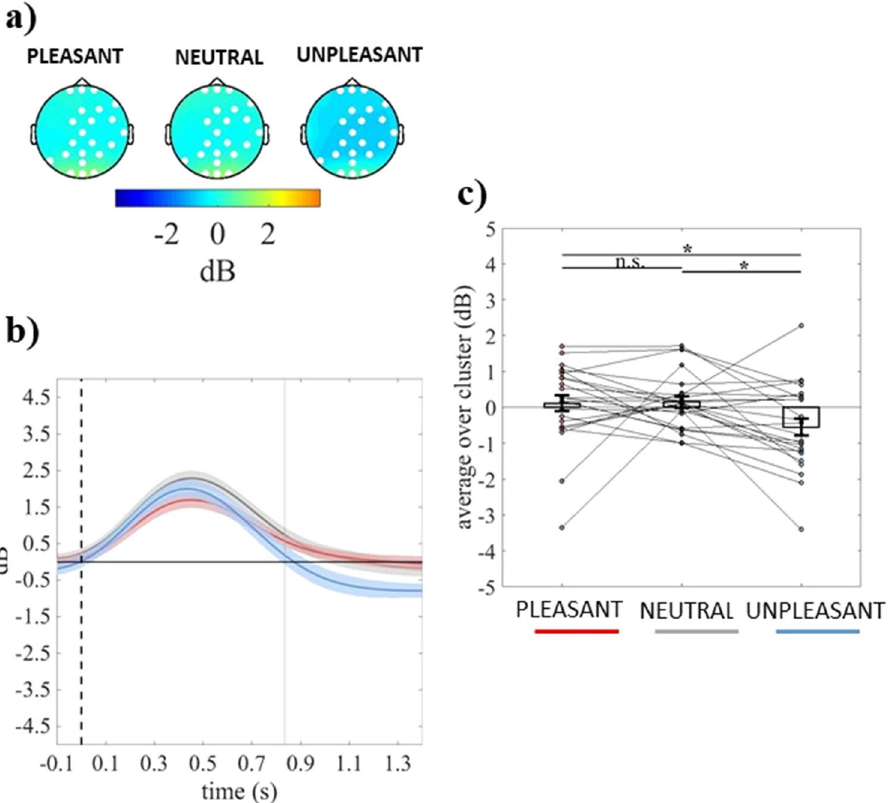
Figure 5. ( a ) Topography of the mean event-related theta power (dB) of individuals without dysphoria averaged over the significant time points (836 to 1400 ms time window) for pleasant, neutral, and unpleasant conditions. ( b ) Time course of grand-average event-related theta power of individuals without dysphoria averaged over the significant electrodes for pleasant (red line), neutral (grey line), and unpleasant (light blue line) conditions. Shaded areas represent ± standard error of the mean (SEM) and the gray line represents the beginning of the significant time window (836 ms). ( c ) Mean event-related theta power of each participant (in the group without dysphoria) averaged over the significant electrodes and time points for pleasant, neutral, and unpleasant conditions. Each circle represents one participant; colored frames represent the mean event-related theta power across all participants and the solid black lines represent ± SEM. * p <